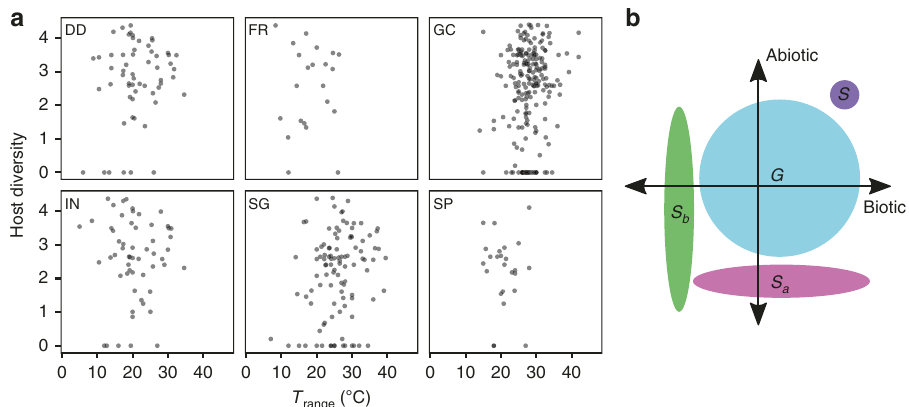
Fig. 3 Biotic vs. abiotic niche breadth. a Biotic niche breadth is represented by log-transformed host phylogenetic diversity calculated from the processed host phylogeny, and abiotic niche breadth by T range . Panels show the different biological processes, disease development (DD, N = 59), fruiti fi cation (FR, N = 22), growth in culture (GC, N = 209), infection (IN, N = 57), spore germination (SG, N = 105) and sporulation (SP, N = 25). b Schematic of niche breadth on biotic and abiotic axes for a true specialist ( S , purple), true generalist ( G , blue), biotic specialist with wide climatic tolerances ( S b , green) and abiotic specialist with broad host range ( S a ,